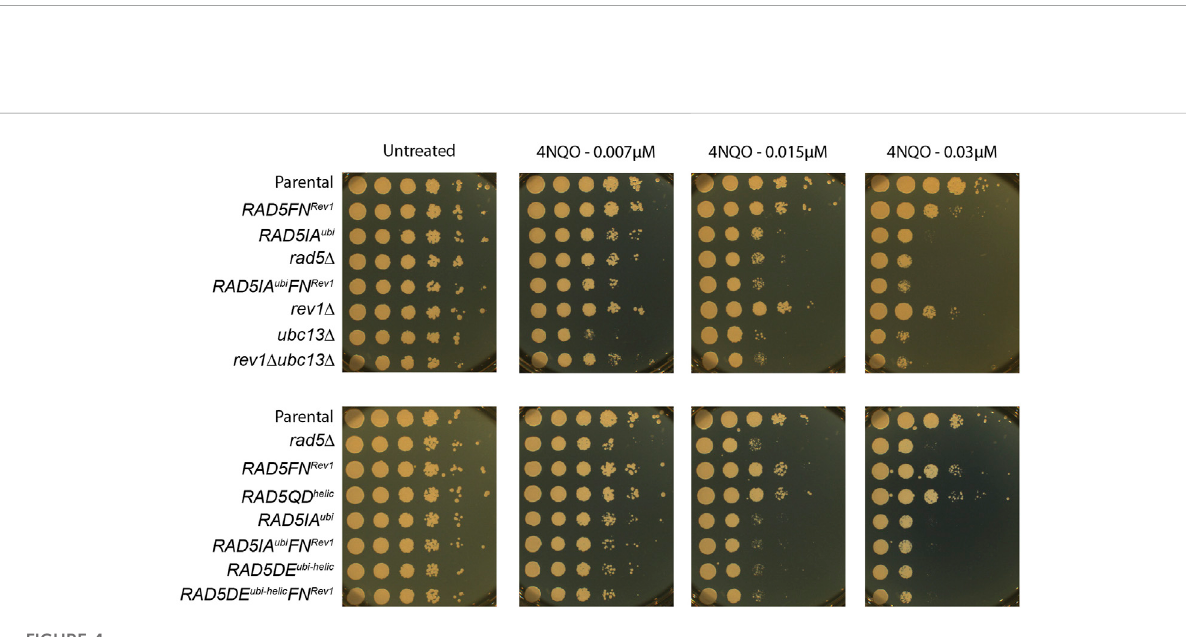
FIGURE 4 Sensitivity to 4NQO treatment of the different RAD5